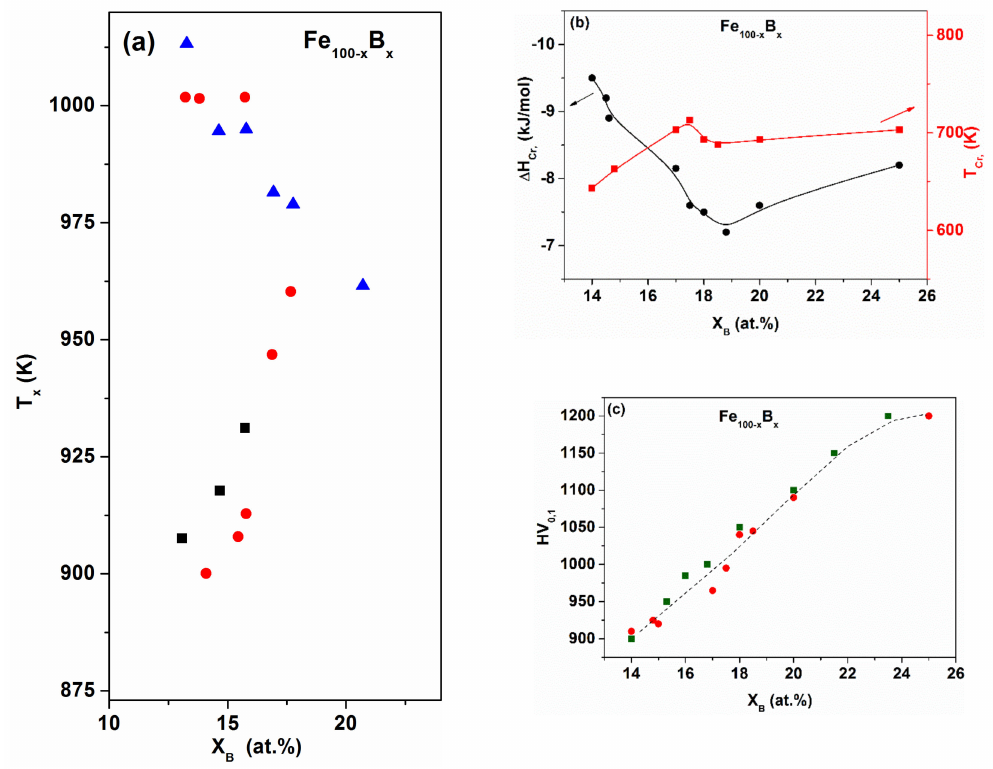
Figure 4. Binary Fe 100 − x B x glasses. Boron content vs. ( a ) onset of the crystallization temperature ( T x ) as derived from di ff erential scanning calorimetry (DSC) measurements; ( b ) crystallization enthalpy ( ∆ H cryst ) and temperature ( T cr ) and ( c ) micro hardness ( HV ). Adapted from [50], with permission from Elsevier,